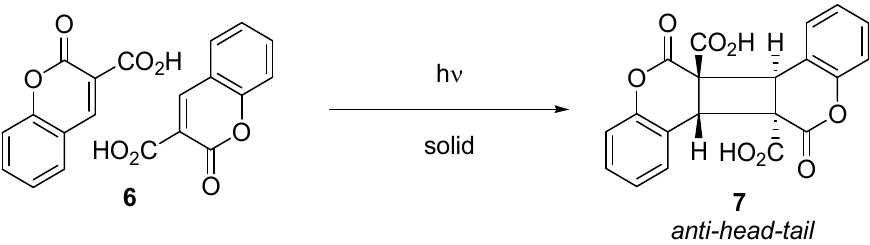
Scheme 2. Photodimerization of coumarin-3-carboxylic acid in the solid